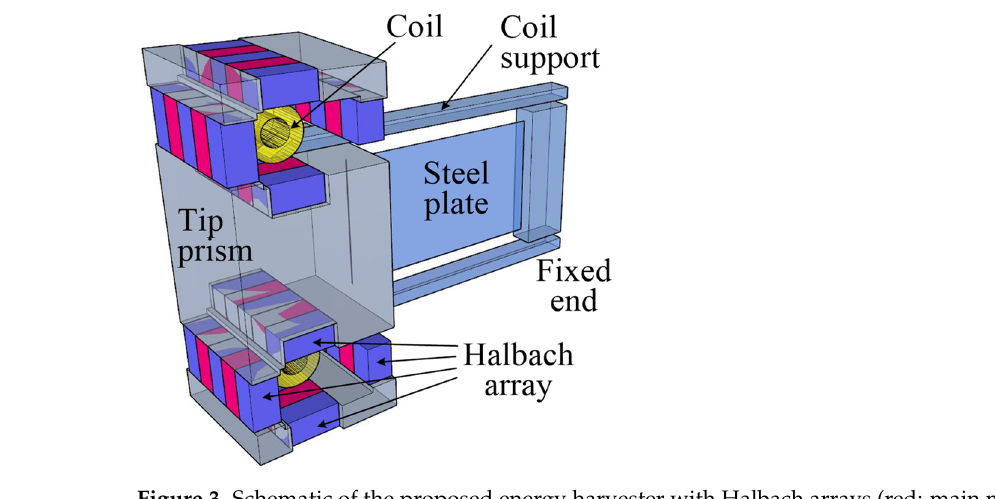
Figure 3. Schematic of the proposed energy harvester with Halbach arrays (red: main magnet, blue: transit magnet).